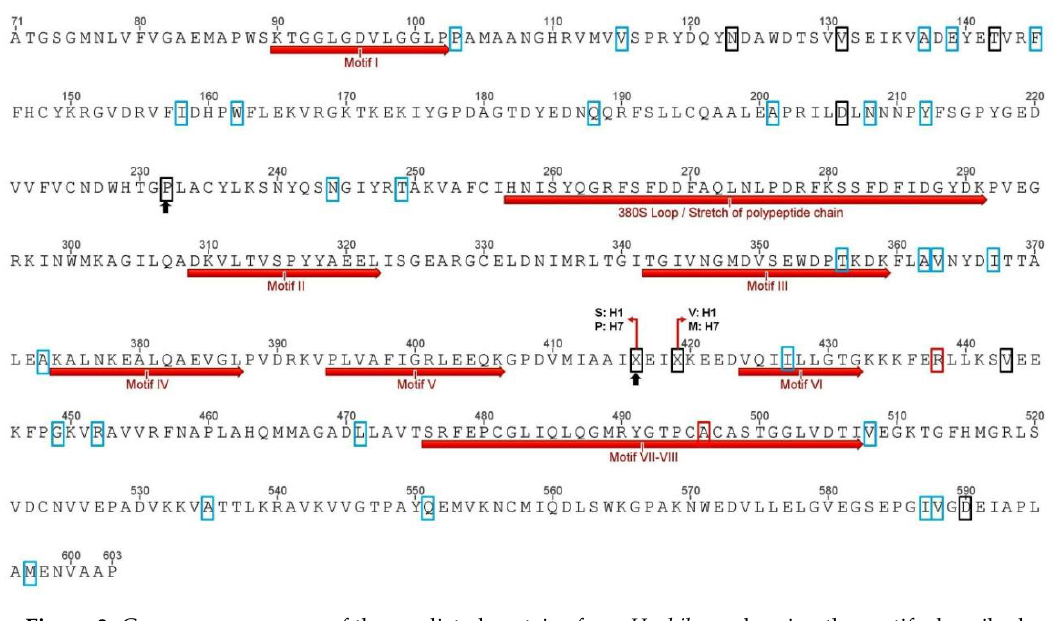
Figure 3. Consensus sequence of the predicted proteins from H. chilense showing the motifs described by Leterrier et al. [44] conserved in waxy proteins. Squares indicate substitution sites (blue for wheat, red for barley and black for both ones), and arrows point relevant changes found in the novel alleles.